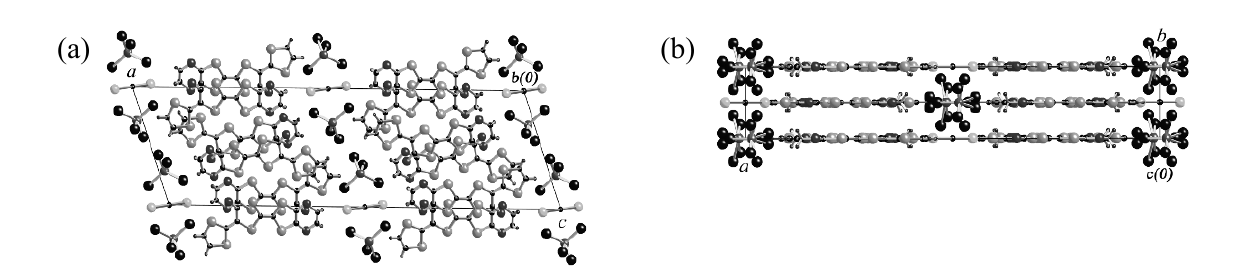
Figure 44. Stacking views of ( EDO–TTFVO ) b − and (b) c −